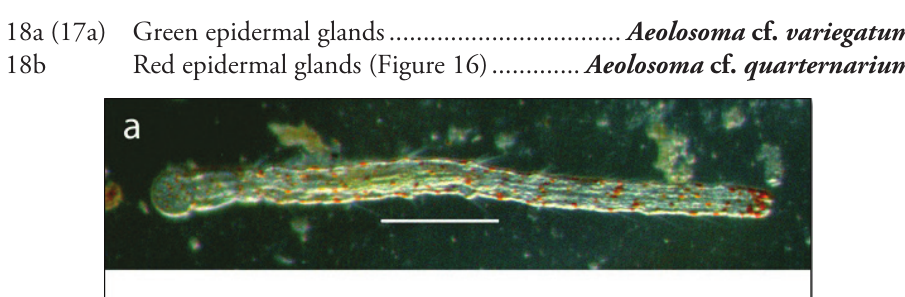
Figure 15. Pristina cf. leidyi : A lateral photo of anterior end showing elongate proboscis (scale 200 µm) B drawing of typical bundle of dorsal chaetae C drawing of typical ventral chaeta.